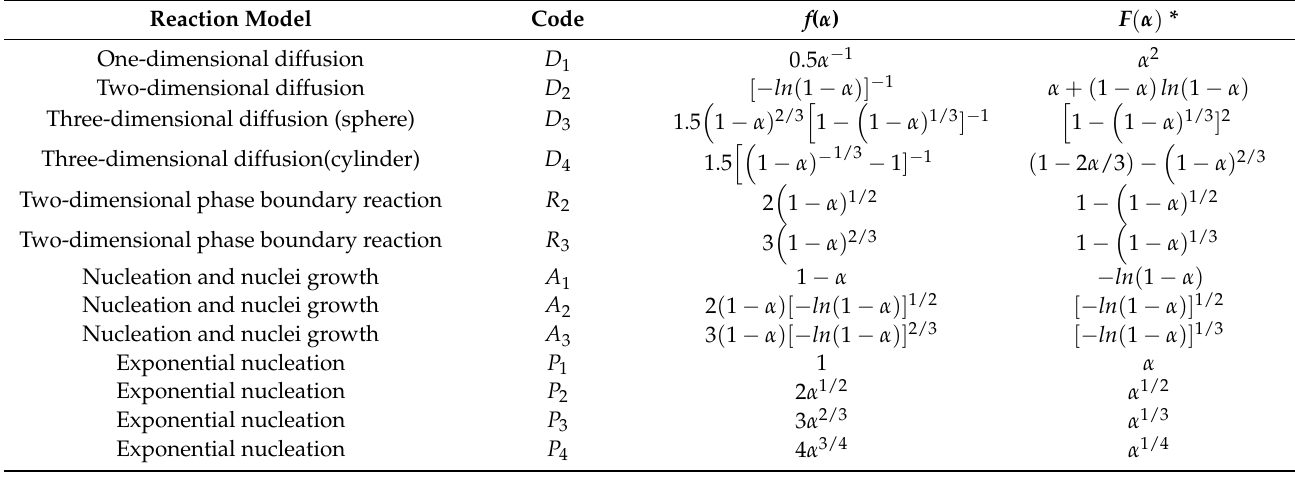
Table 3. Kinetic models for solid–gas reactions [51,75].